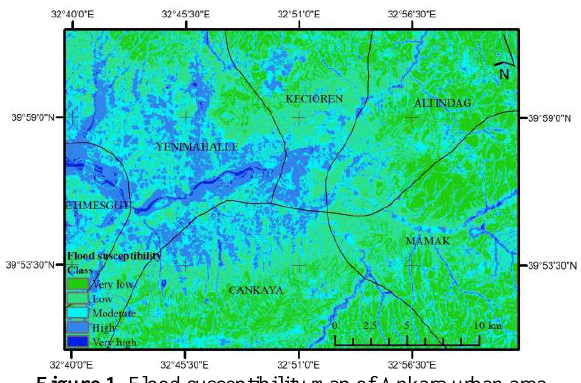
Figure 1. Flood susceptibility map of Ankara urban